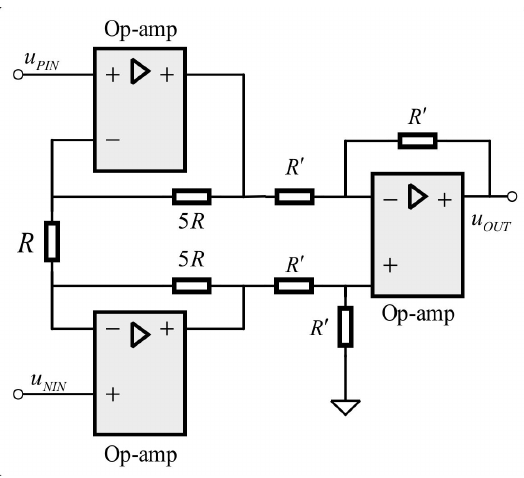
Figure 10. Differential instrumentation